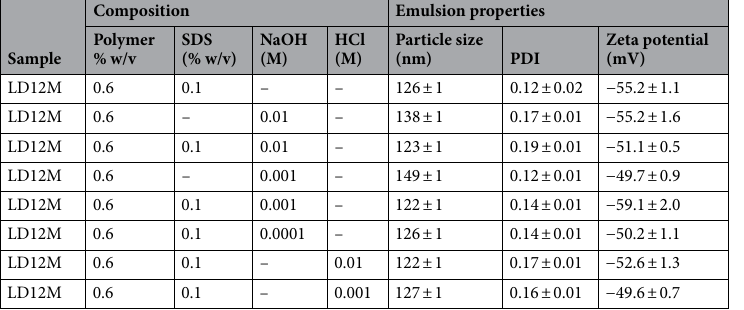
Table 3. Summary of particle size and Zeta potential of emulsions of alcohol-acidolyzed PLA in alkaline and acid environments.